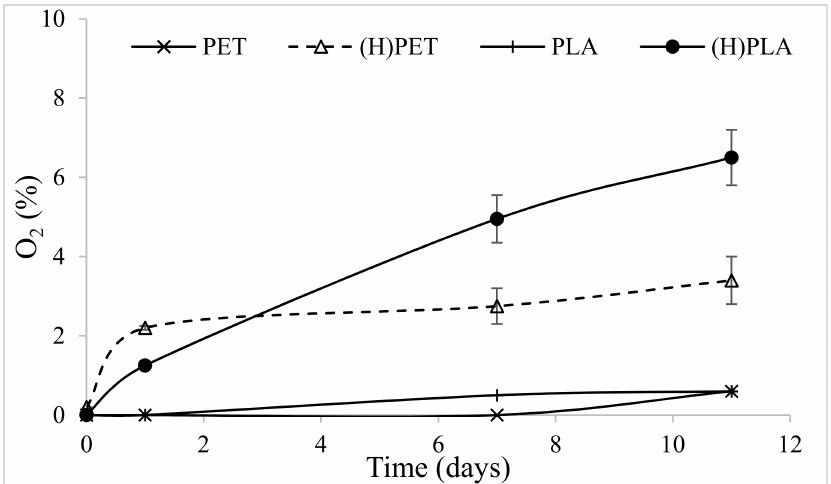
Figure 2. Time-course of O 2 concentration as measured by laser spectroscopy in PLA and PET bottles, empty or filled with water